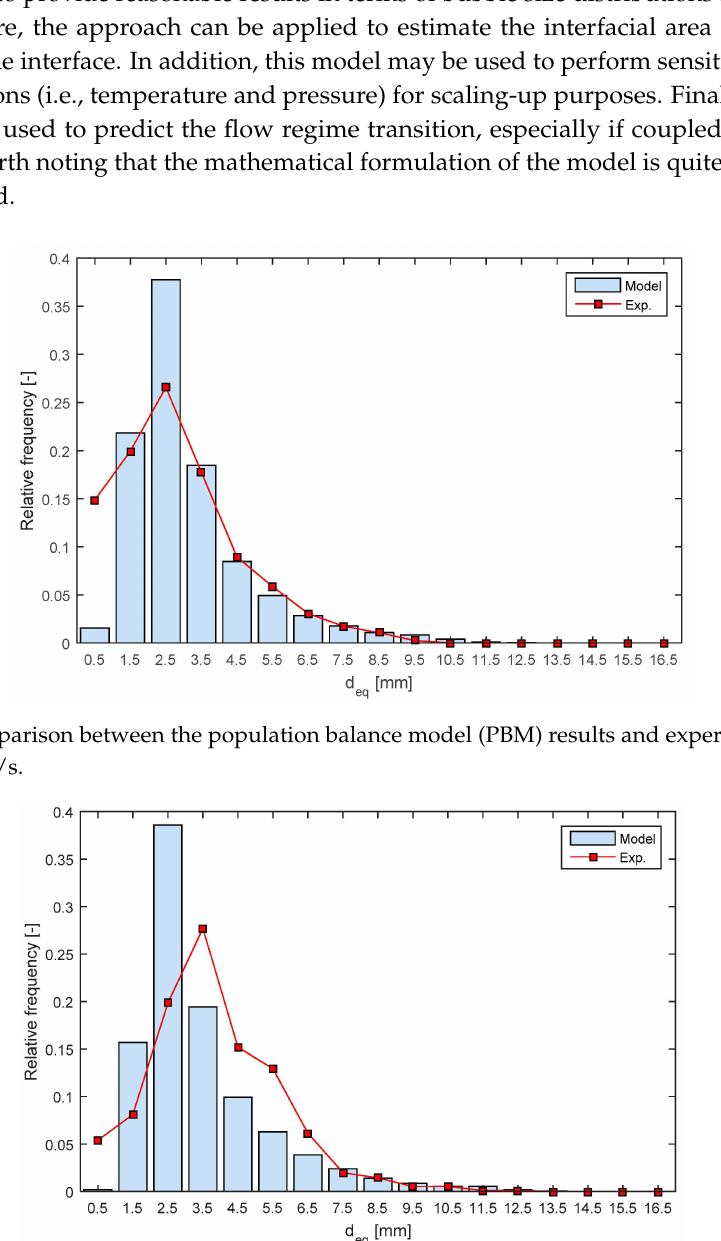
Figure 3. Comparison between PBM results and experimental data: U G = 0.0074